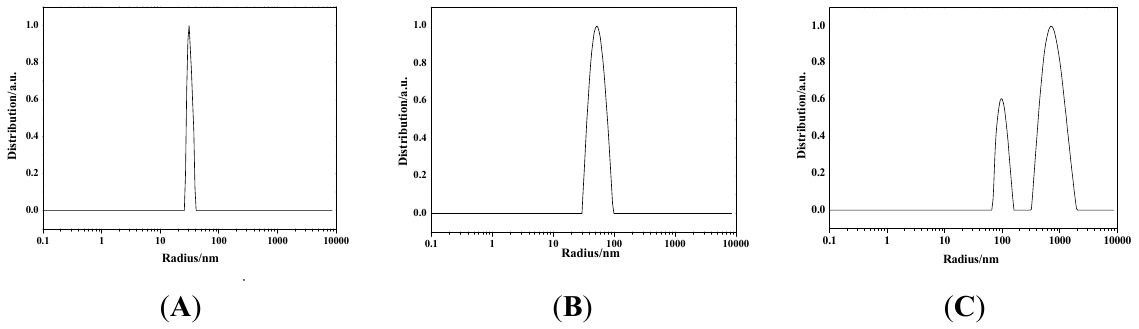
Figure 3. SEM, TEM and EDS images at different magnifications. ( a , b ) for SEM of SiO 2 ; ( c ) for SEM of SiO 2 -Cl; ( d ) for SEM of SiO 2 -Im; ( e ) for SEM of SiO 2 Im + Cl − SiO 2 ; ( f , g ) for TEM of SiO 2 ; and ( h ) for TEM of SiO 2 Im + Cl − SiO 2 respectively; ( i ) for EDS elemental mapping images of the Si, O, N, Cl, P, and W, respectively.